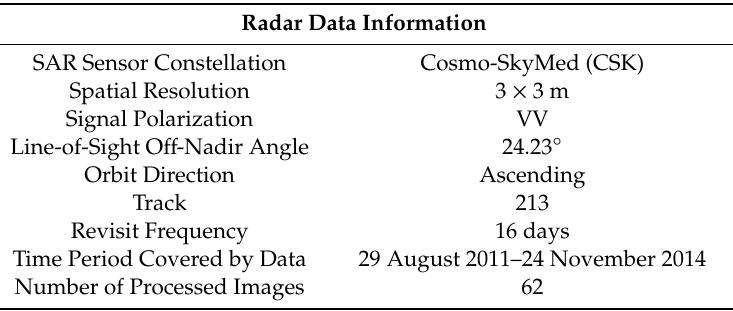
Table 1. Information regarding the SAR data used in this